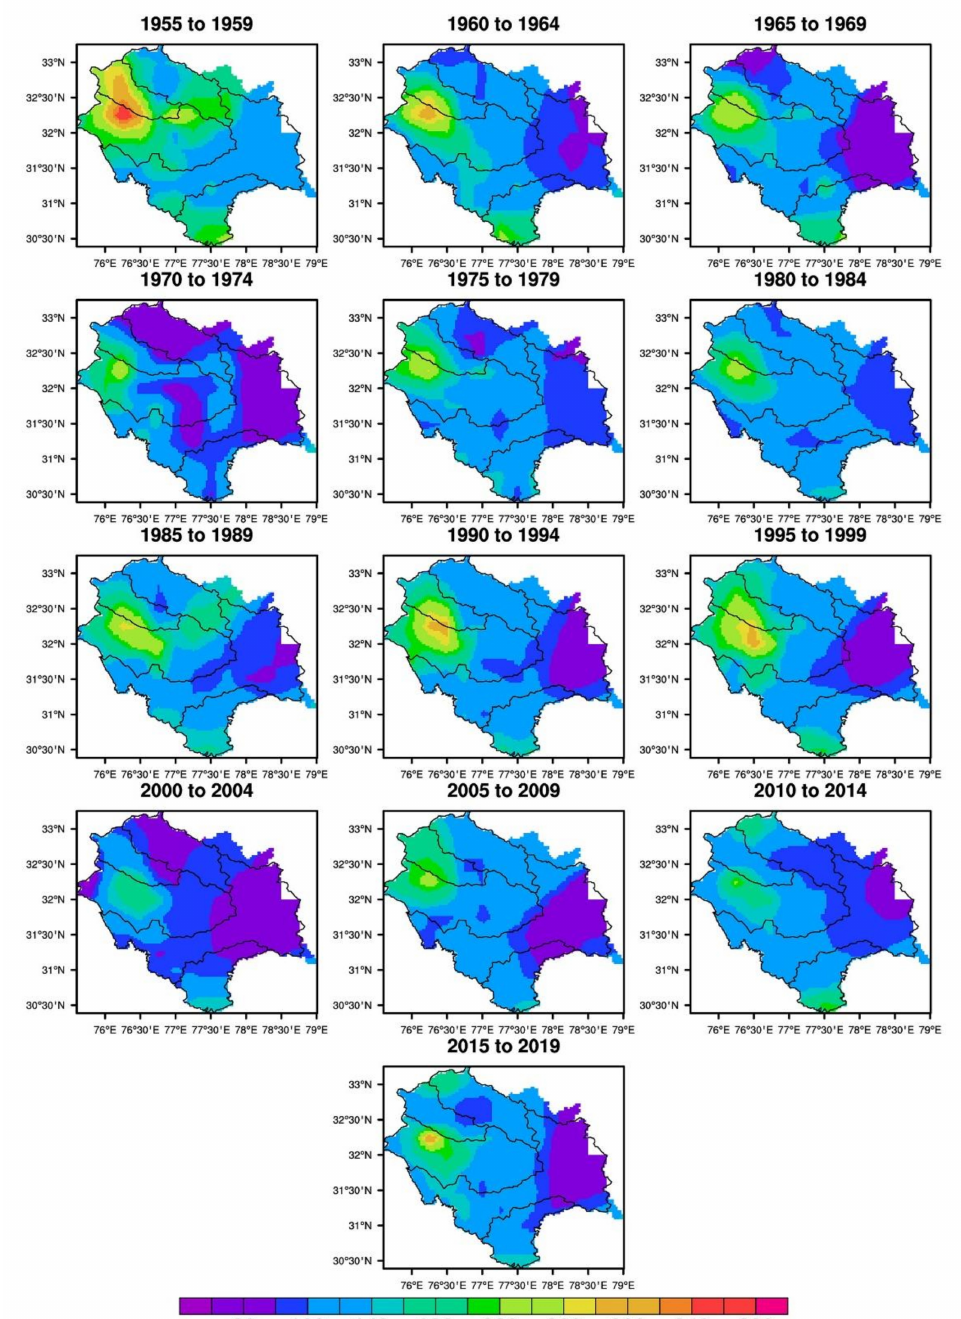
Figure 3. Pentads showing total annual rainfall in five river basins of the Himachal Pradesh. Each pentad shows the mean of the five years from 1955 to